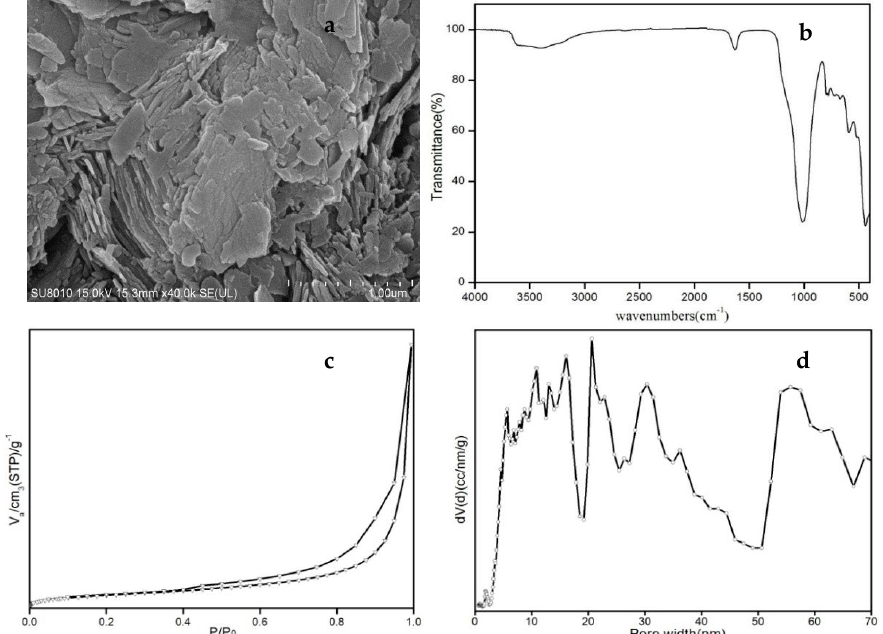
Figure 5. SEM photomicrograph of the glassy surface of p-Cp ( a ), FTIR spectrum of p-Cp ( b ), adsorption isotherms of p-Cp ( c ), and pore-size distribution of p-Cp ( d ).